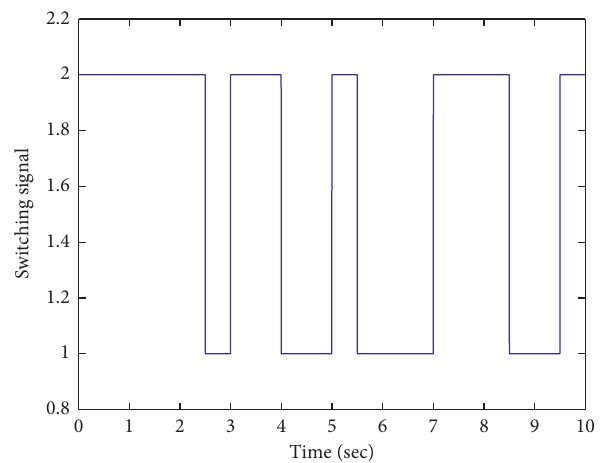
Figure 5: The response of the giving switching signal σ ( t )